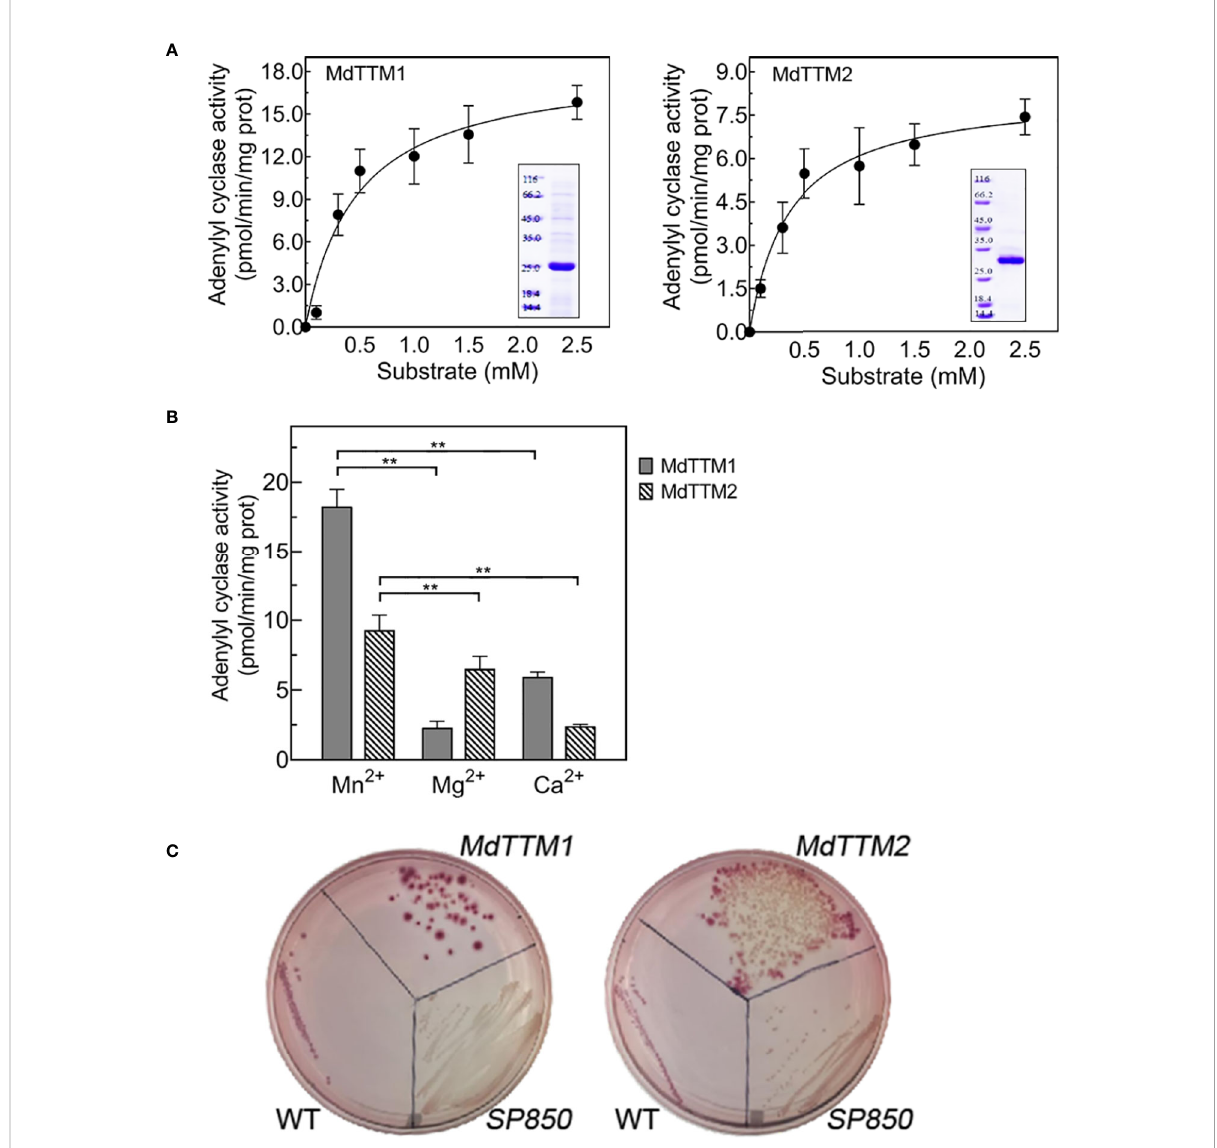
FIGURE 3 Adenylyl cyclase (AC) activity analysis of MdTTM1 and MdTTM2. (A) Enzymatic activity of MdTTM1 and MdTTM2 in response to various concentrations of ATP. The fi tted curve was added with GraphPad Prism (ver. 9.4.0). The R 2 of MdTTM1 and MdTTM2 fi tted curves were 0.93 and 0.92, respectively. The icons show the SDS-PAGE analysis of two af fi nity recombinant proteins. The molecular weight of MdTTM1 was equal to 25 kDa, and that of MdTTM2 was greater than 25 kDa. (B) Enzymatic activity of MdTTM1 and MdTTM2 with the support of different divalent cations: Mn 2+ , Mg 2+ , and Ca 2+ . The values are the mean of three independent replicates. Error bars represent standard deviation (** P < 0.01). The catalytic rate was calculated by determining the cAMP generated from a reaction mixture containing 50 m g of puri fi ed protein, 2.5 mM divalent cation, and ATP as the substrate. (C) Functional complementation of an AC-de fi cient E . coli cyaA mutation with MdTTM1 and MdTTM2. Colonies of host cells transformed with a recombinant vector are displayed with red color, while cells harboring an empty vector remain with white